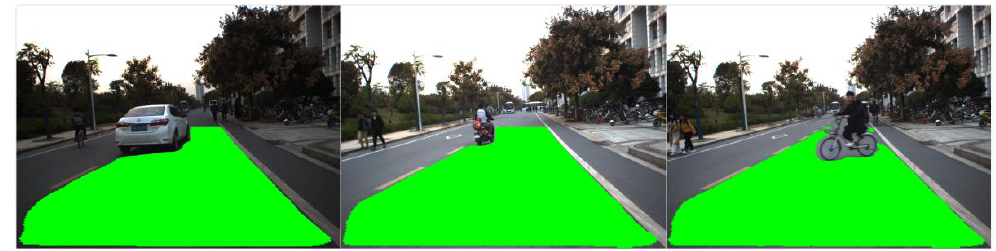
Figure 13. Detection results in the presence of various types of other road users.